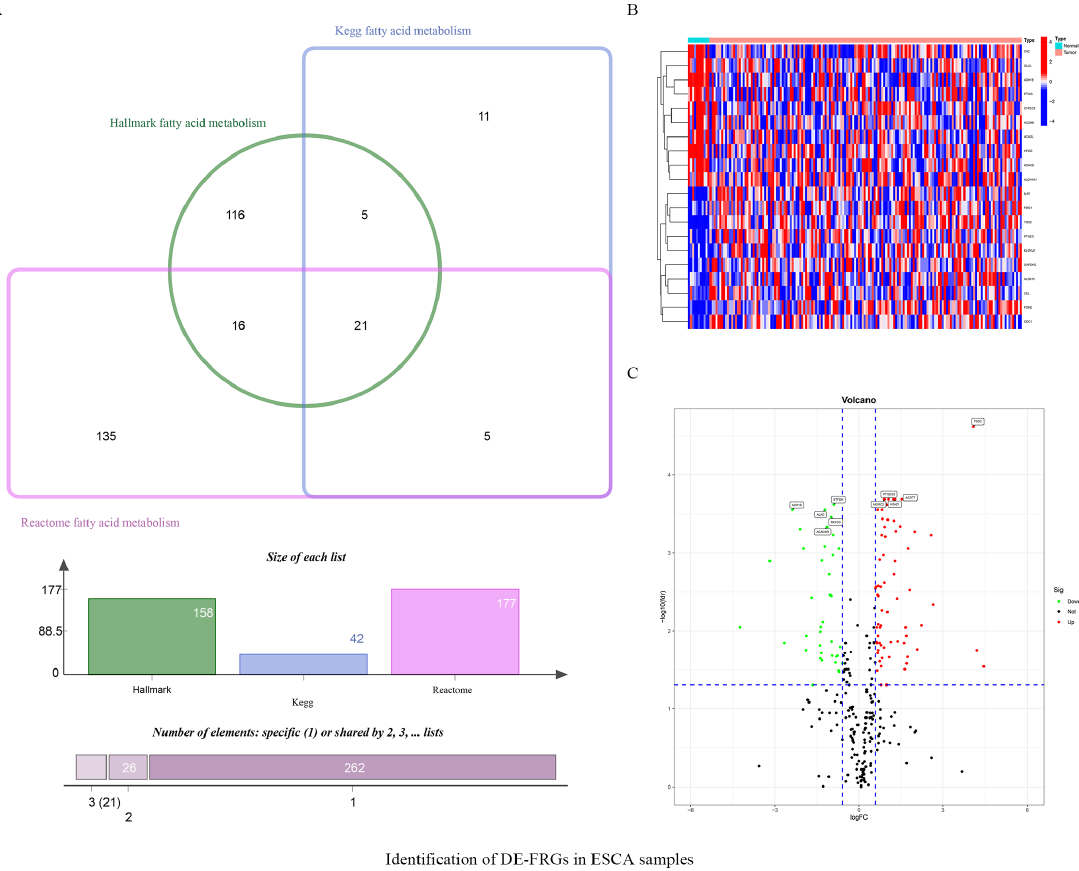
Figure 1. Identification of DE-FRGs in ESCA samples. ( A ) 309 fatty acid metabolism-related genes from Kegg, Hallmark and Reactome. ( B ) Heatmap display the upregulated and downregulated fatty acid metabolism − related DEGs (top 10, respectively, p < 0.05). ( C ) Volcano plot of fatty acid metabolism-related DEGs (only displaying 10 DE-FRGs). Table 1. Identification of differentially expressed fatty acid metabolism-related genes.